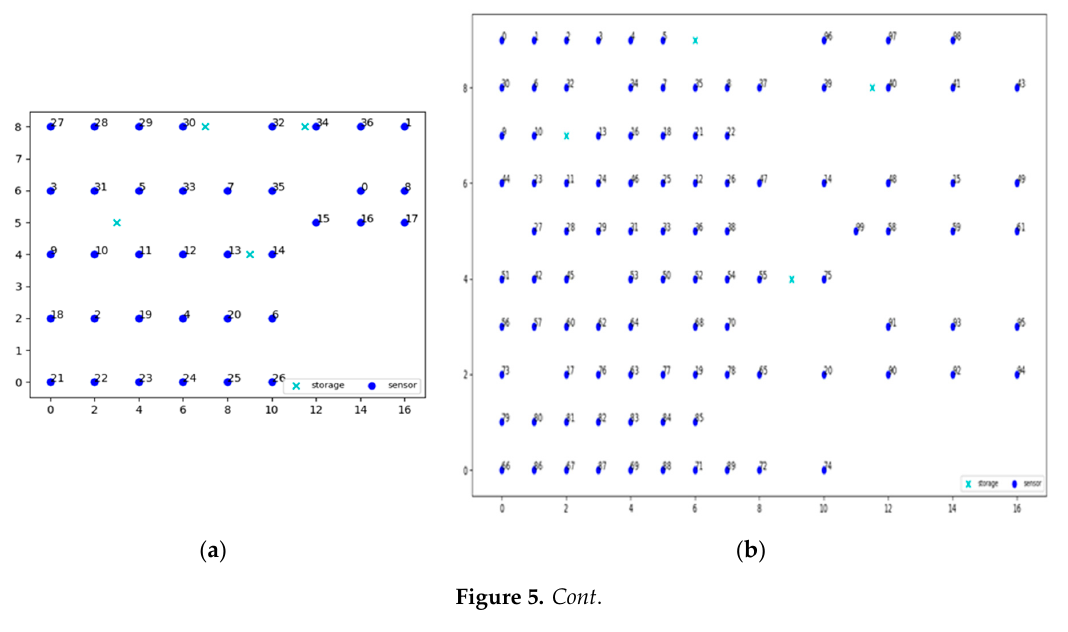
Figure 5. Represents the density graph where the sensor nodes are the vertices and the edges connect those whose distance belong in dangerous distance area ( a ) sparse graph with ann = 1.4, ( b ) medium dense with ann = 9.2 ( c ) very dense with ann = 22.6.